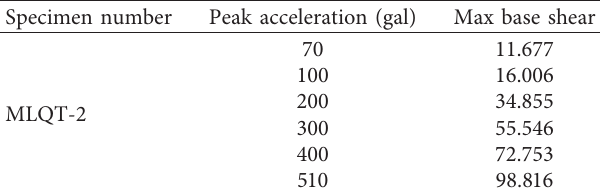
Table 6: Maximum shear with peak acceleration (MLQT-2).